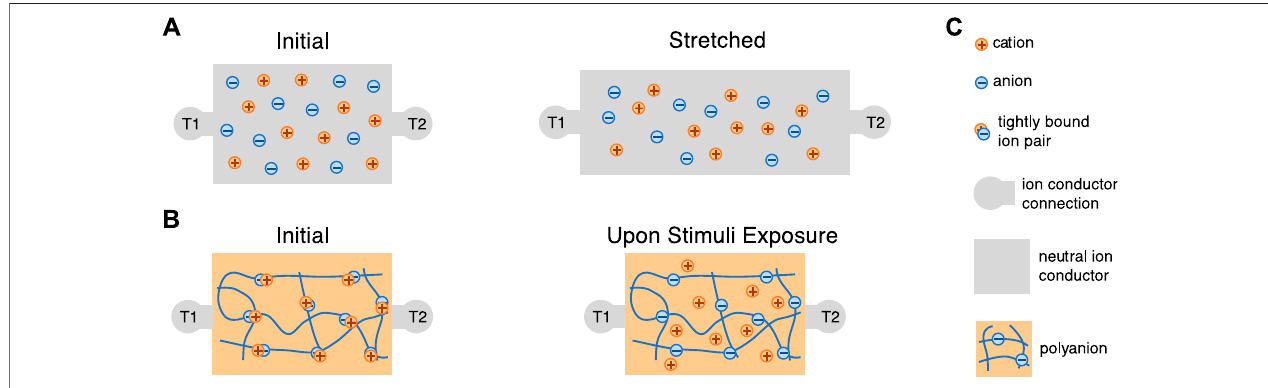
FIGURE 5 | Schematics of two concepts for resistive senors. (A) Direct resistive sensing via shape change of the stretchable resistor during mechanical deformation that results in a longer ionic conduction path and reduced cross-sectional area/ions per cross-section, and consequently an increase in resistance. (B) Resistivesensingofstimuli via changeinthe concentrationofmobileions.Depicted here isanincrease in theconcentrationofmobileions,which would correspond toa decrease in resistance. (C) Legend for both schematics.